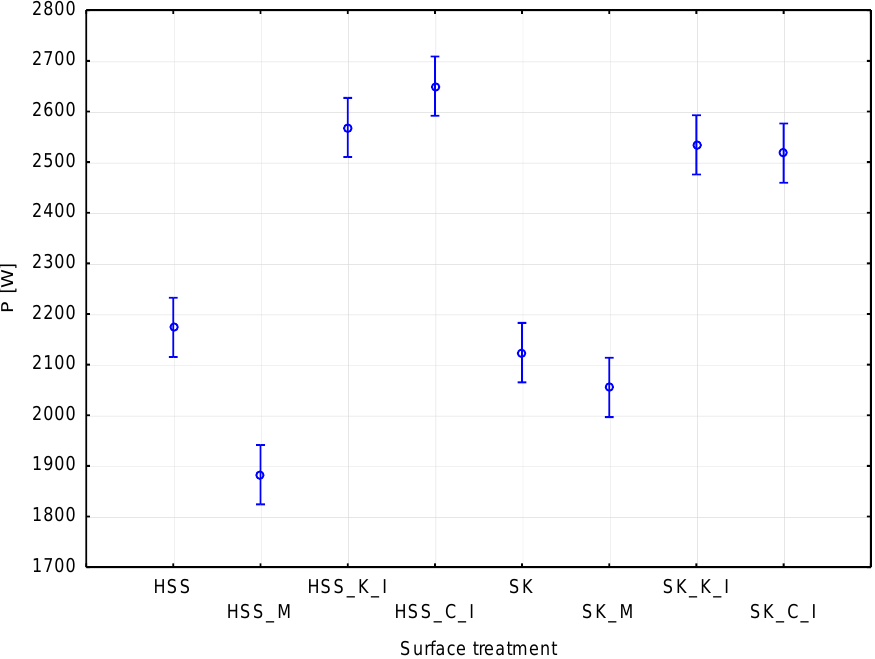
Figure 6. Average performance values depending on the coating used.